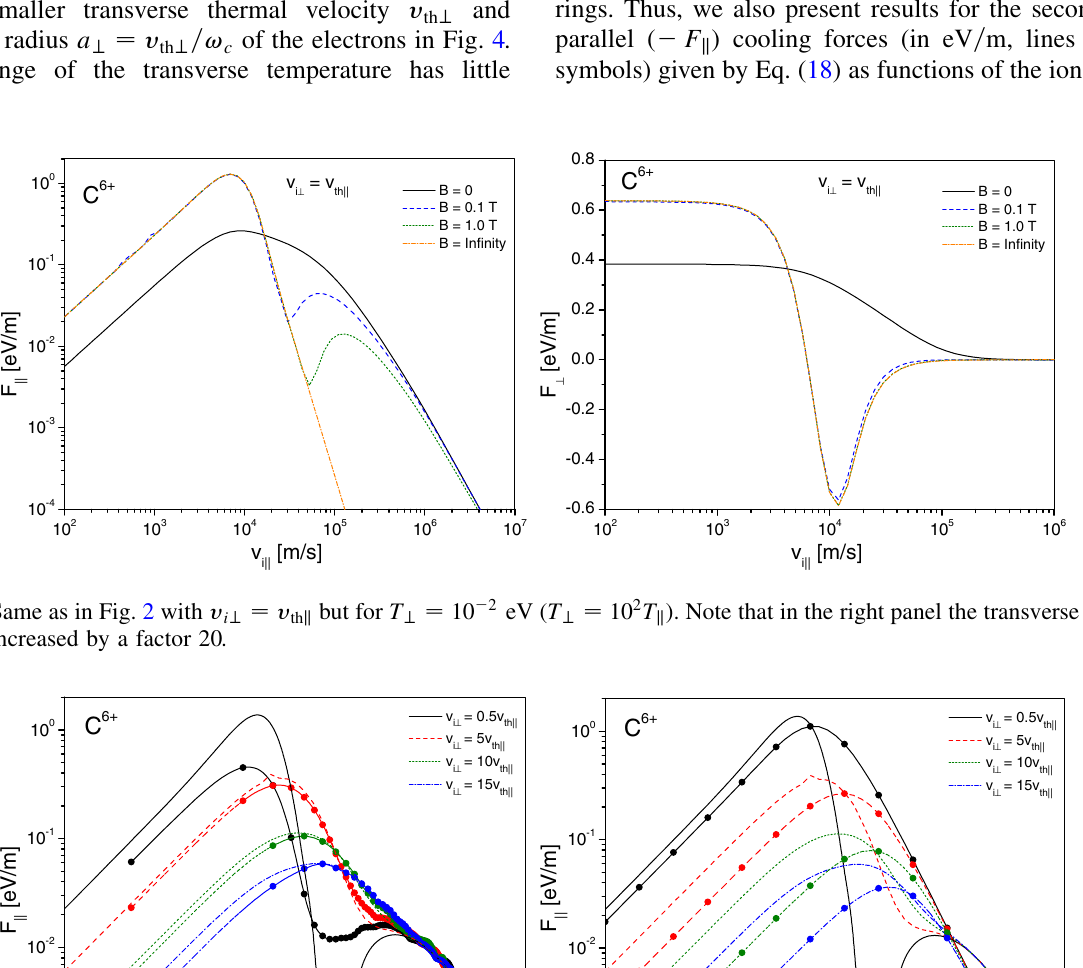
¼ FIG. 5. Left panel: Longitudinal cooling force (cid:1) F k (in eV = m ) for the C 6 þ ion as function of v (in m = s ) for (cid:2) ¼ (cid:2) D k and v i k i ? 5 v 10 v 15 v 0 : 5 v th k (solid lines), v i ? ¼ th k (dashed lines), v i ? ¼ th k (dotted lines), and v i ? ¼ th k (dash-dotted lines). For calculation of the theoretical cooling force (18) (the lines without symbols), the same set of parameters are used as in Fig. 1 with the value of a magnetic field B ¼ 0 : 1 T . The CTMC results are shown by the lines with filled circles. Right panel: Same as in the left panel but the present perturbative treatment (represented in the left panel by the lines without symbols) is compared with the PF (the lines with symbols) as given by Eq. (50) for v eff ¼ 2 v th k . See the text for further